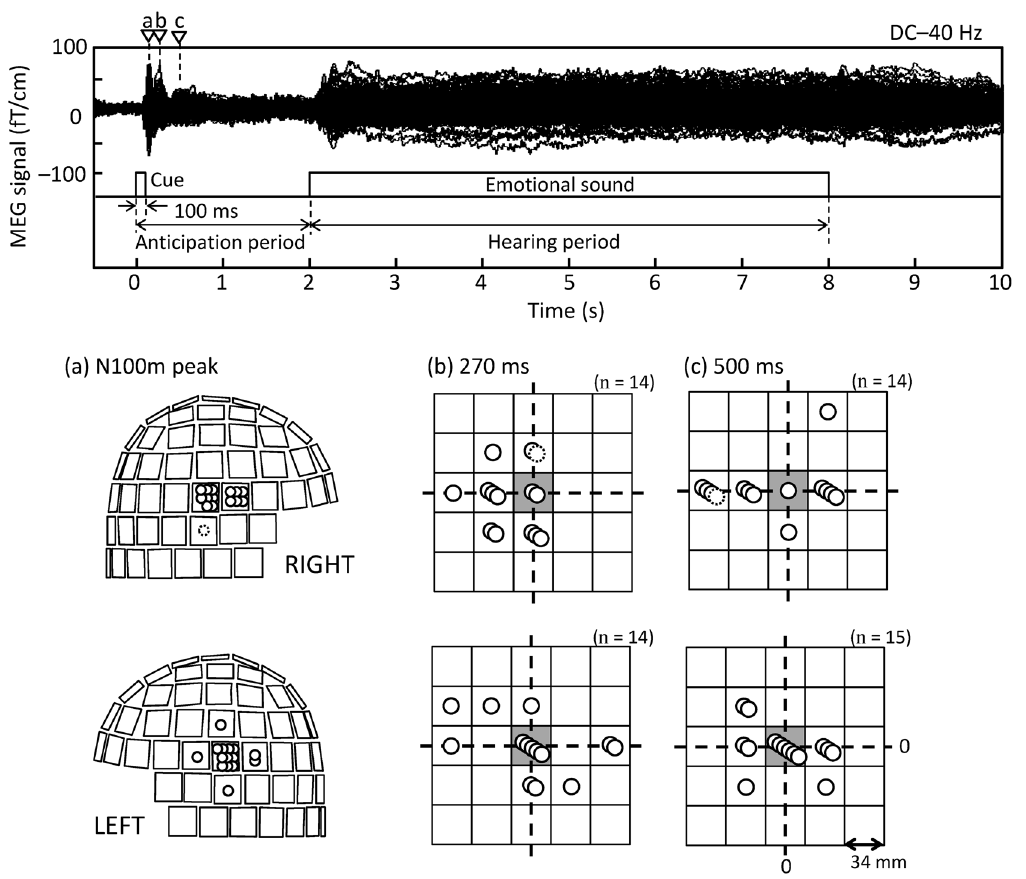
Figure 2. Time traces and maximum locations of magnetic field gradients. (top) An example of magnetic field gradients obtained by all gradiometers from one typical participant. Reverse triangles indicate the time points at the N100m peak (a) and broad peaks of 0.27 s (b) and 0.5 s (c). (bottom) (a) Positions of the gradiometer pairs that detected the strongest N100m signal in each individual; the helmet is shown from right (top) and left (bottom). (b, c) Sensor positions for the strongest 0.27-s (b) and 0.5-s (c) peaks given in spatial relationship to the sensor that picked the strongest N100m response in each individual (grey shading); the squares illustrate the sensor pairs (as in the helmets on the left), separated by 34 mm. Each stacked circle corresponds to one participant. Dotted circles refer to local maxima within the temporal area in a few cases with the global maximum located outside the temporal area. The signals were time-averaged over intervals from 0.2 to 0.35 s (b) and from 0.4 to 0.7 s (c), respectively. A few positions outside the temporal areas were eliminated from the figure. doi:10.1371/journal.pone.0080284.g002 traces show the source waveforms with passband from DC to 40 Hz, with prominent transient responses to the onsets of both sounds, decaying slow shifts (with peaks around 0.27 and 0.5 s)